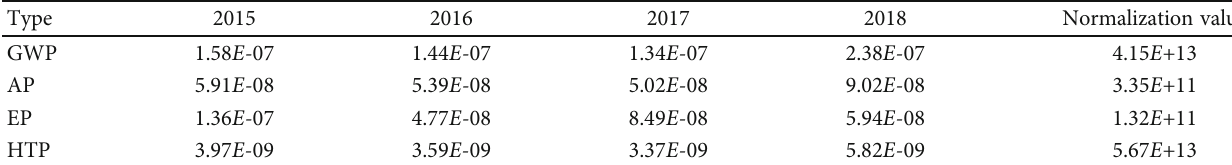
Table 7: Normalization results of environmental impact potential